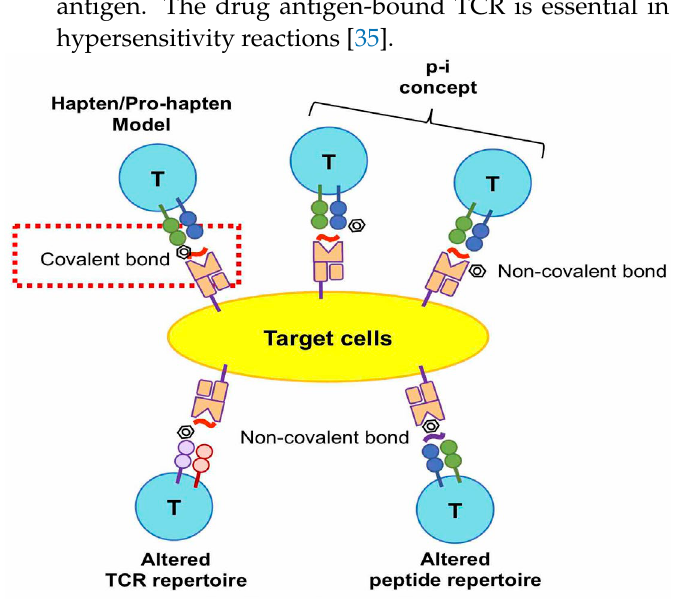
Figure 2. Four hypotheses proposed for the molecular recognition of drugs by TCR in delayed type drug hypersensitivity. The hapten model hypothesizes that a drug or metabolite covalently binds to an endogenous peptide and leads to an immunogenic response. The other three hypotheses suggest non-covalent interactions between drugs, endogenous peptides, TCR, and HLA. The pharmacological interaction with the immune receptor (p-i) concept hypothesizes that the drug interacts with TCR, HLA, or both non-covalently. Altered TCR repertoire and altered peptide repertoire models propose that the drug non-covalently binds on TCR or HLA in the groove region.